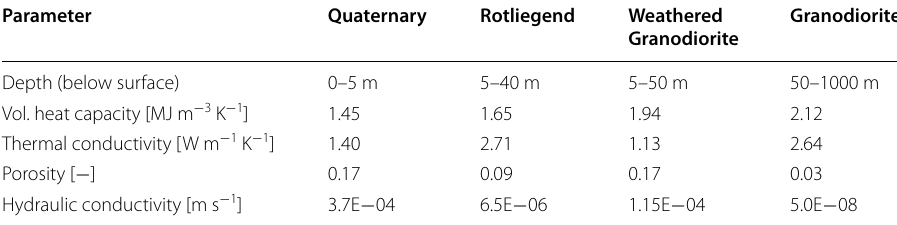
Table 2 Assigned thermal and hydraulic properties Parameter